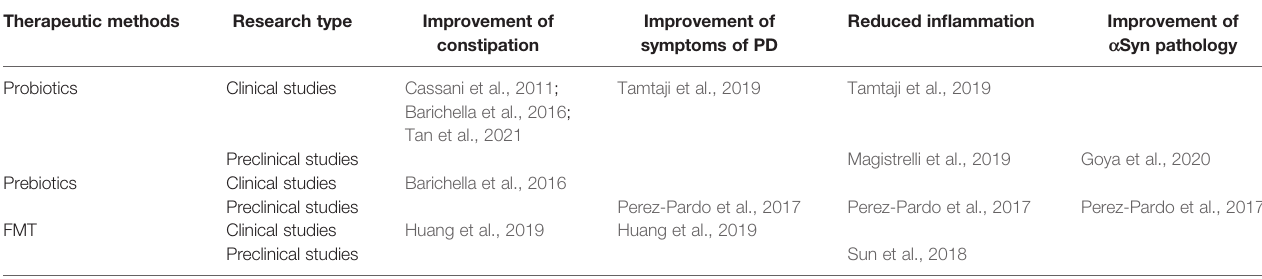
TABLE 2 | A conclusion of microbial therapy in Parkinson ’ s